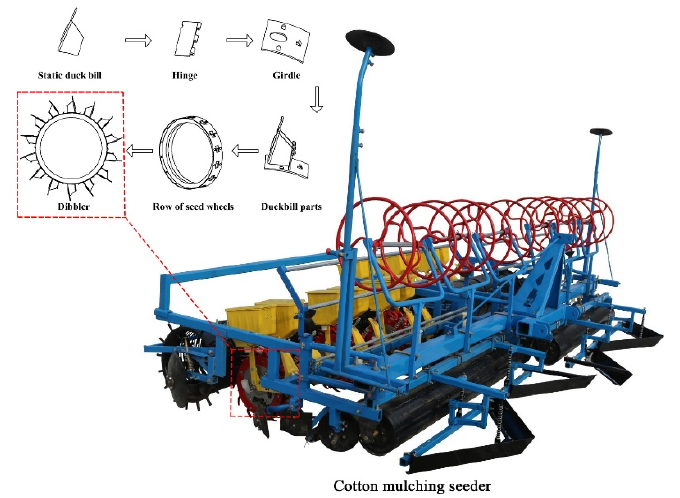
Figure 1. The assembly relationship diagram of duckbill welding parts.